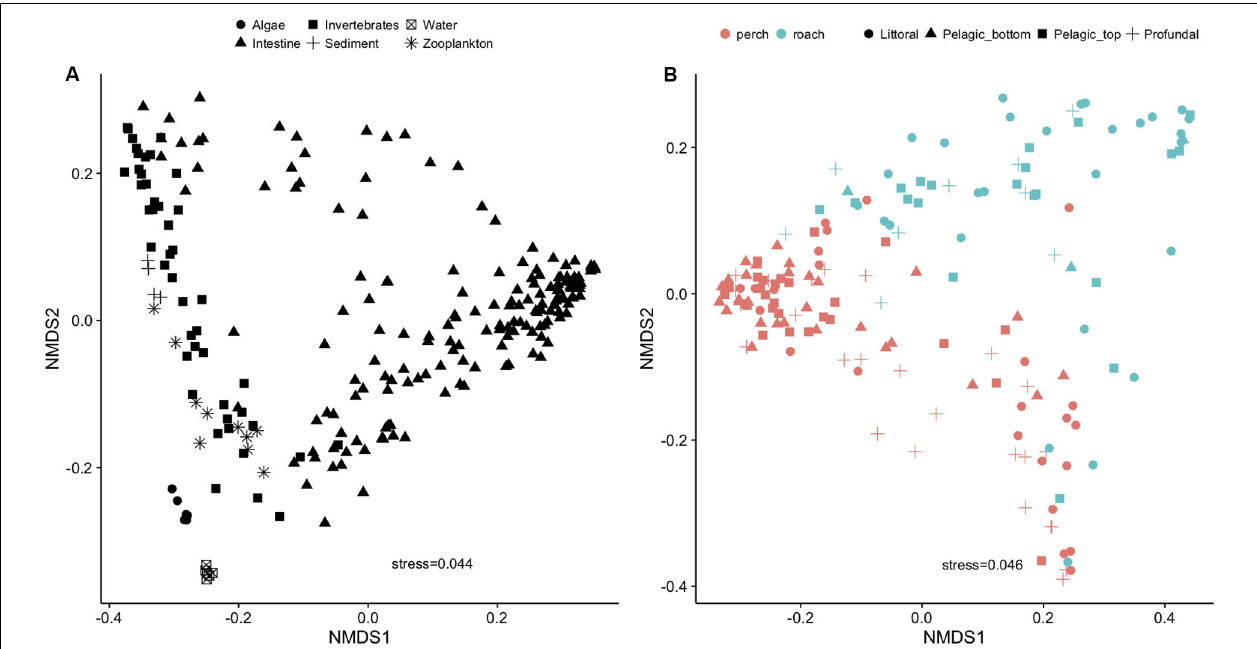
FIGURE 2 | NMDS plot using Bray-Curtis distance showing variations of microbial communities in fish intestine and external dispersal sources (A) and fish species as the main driver for the variation within gut microbial communities (B) .